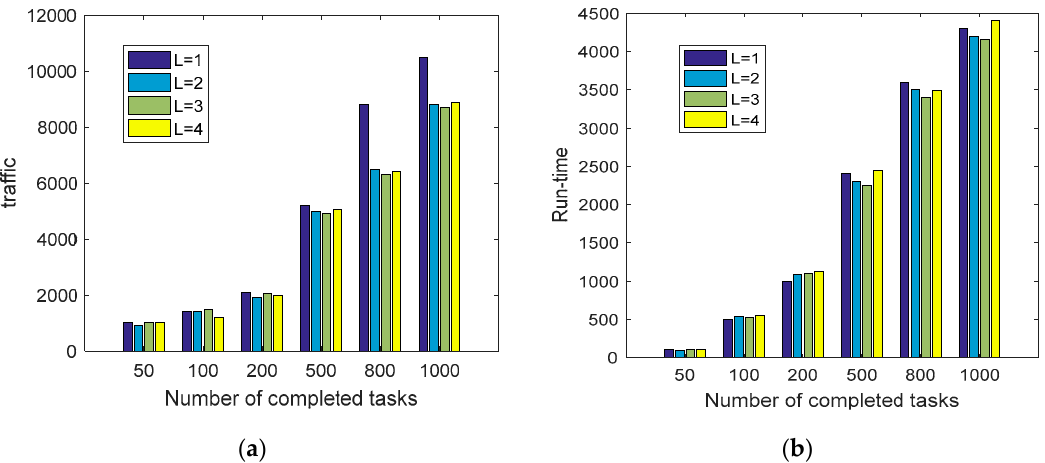
Figure 5. Quantitative analysis with different task numbers. ( a ) The traffic of the improved contract net protocol with different numbers of tasks; ( b ) The run-time of the improved contract net protocol with different numbers of tasks.